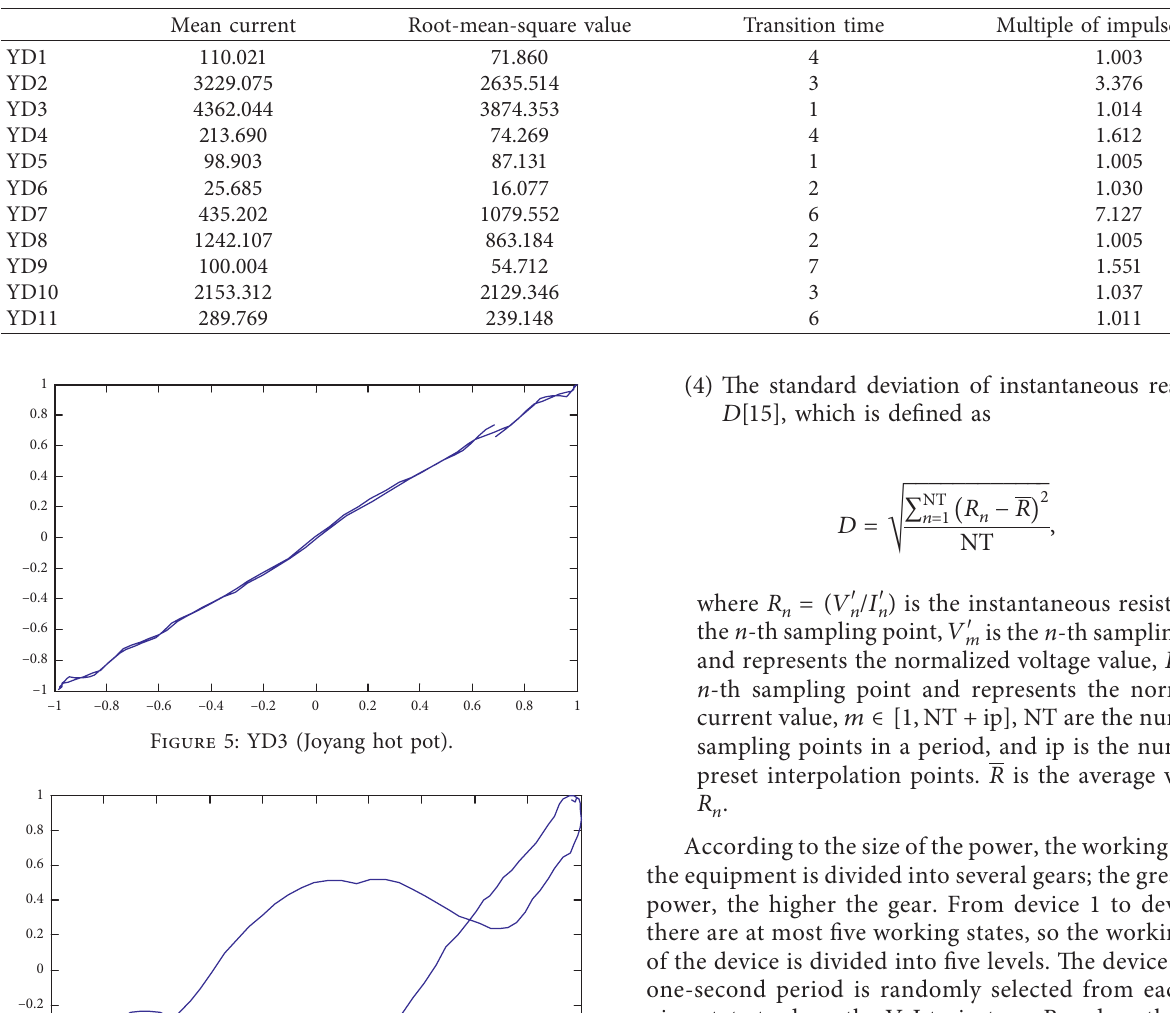
Table 2: Transient eigenvalues.